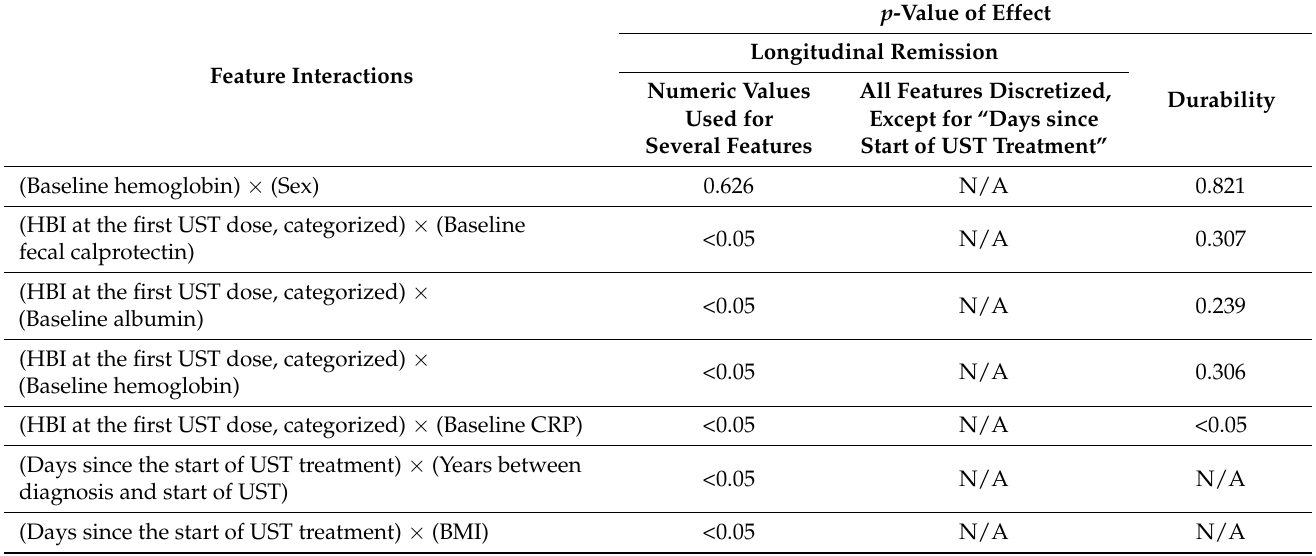
Table A1. Interaction